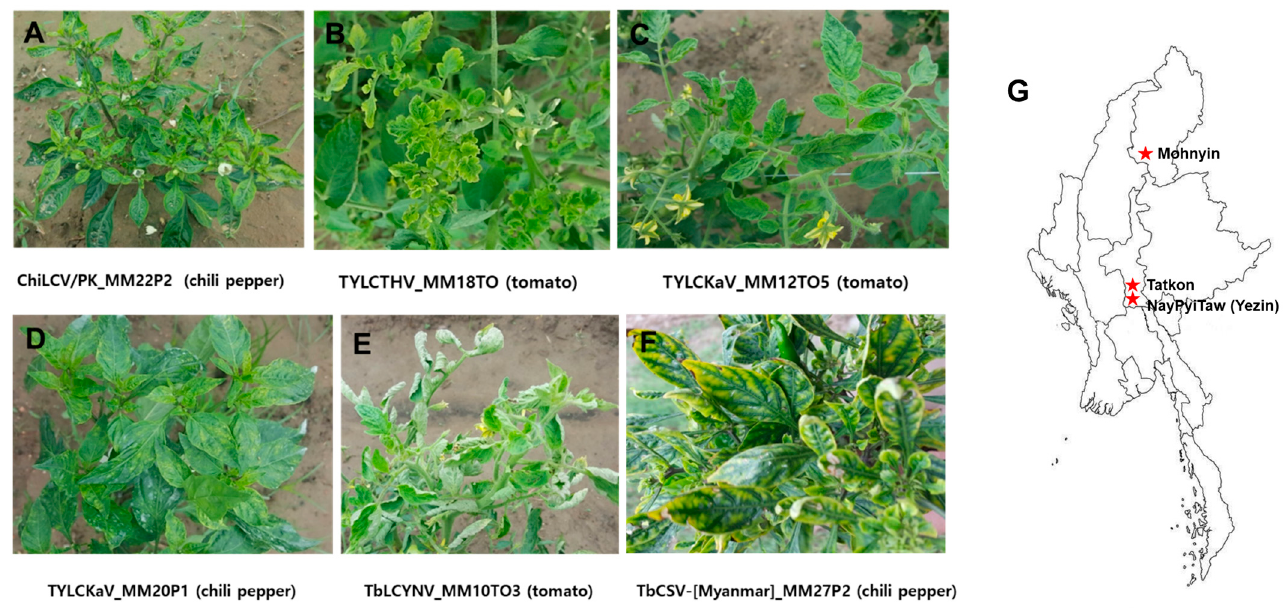
Figure 1. Symptoms observed on tomato and pepper plants collected in Myanmar and a representative map indicating the sampling sites: ( A ) pepper plant showing yellowing, leaf curling, and stunt by ChiLCV/PK (MM22P2), ( B ) tomato plant showing yellowing and leaf curling by TYLCTHV (MM18TO), ( C ) tomato plant showing yellowing and leaf curling by TYLCKaV (MM12to5), ( D ) pepper plant showing yellowing and mosaic by TYLCKaV (MM20P1), ( E ) tomato plant showing yellowing and leaf curling by TbLCYnV (MM10TO3), ( F ) pepper plant showing chlorosis and vein banding by TbCSV-[Myanmar](MM27P2), and (G) geographical sites of sampling in Myanmar. Table 1. Tomato and pepper plants collected from Myanmar and detection of